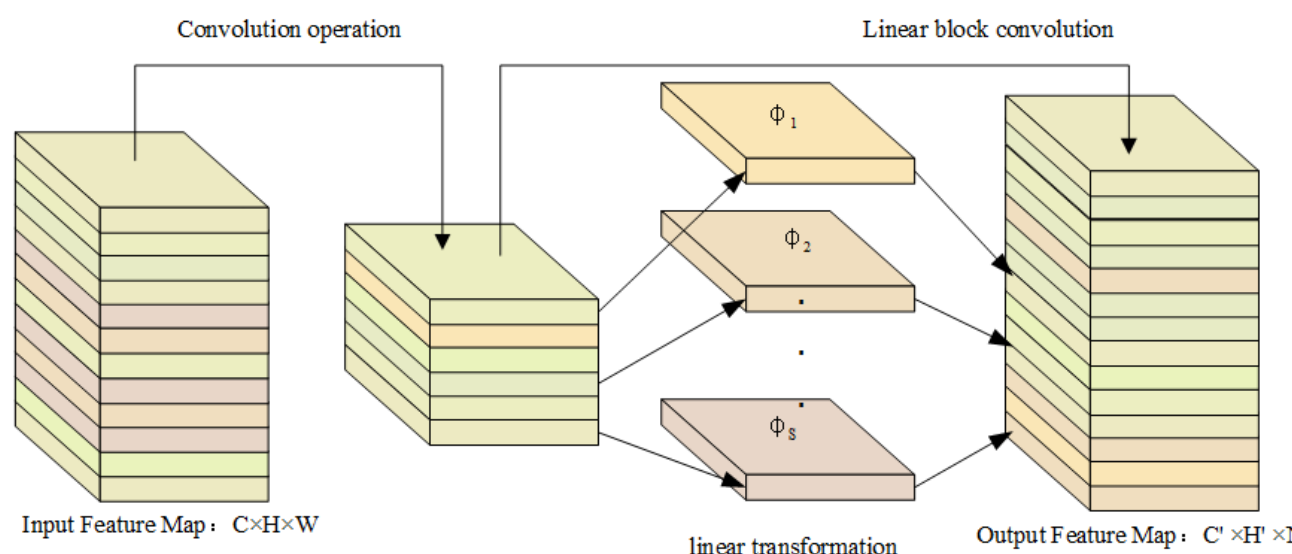
Figure 2. The structure of the Ghost model.